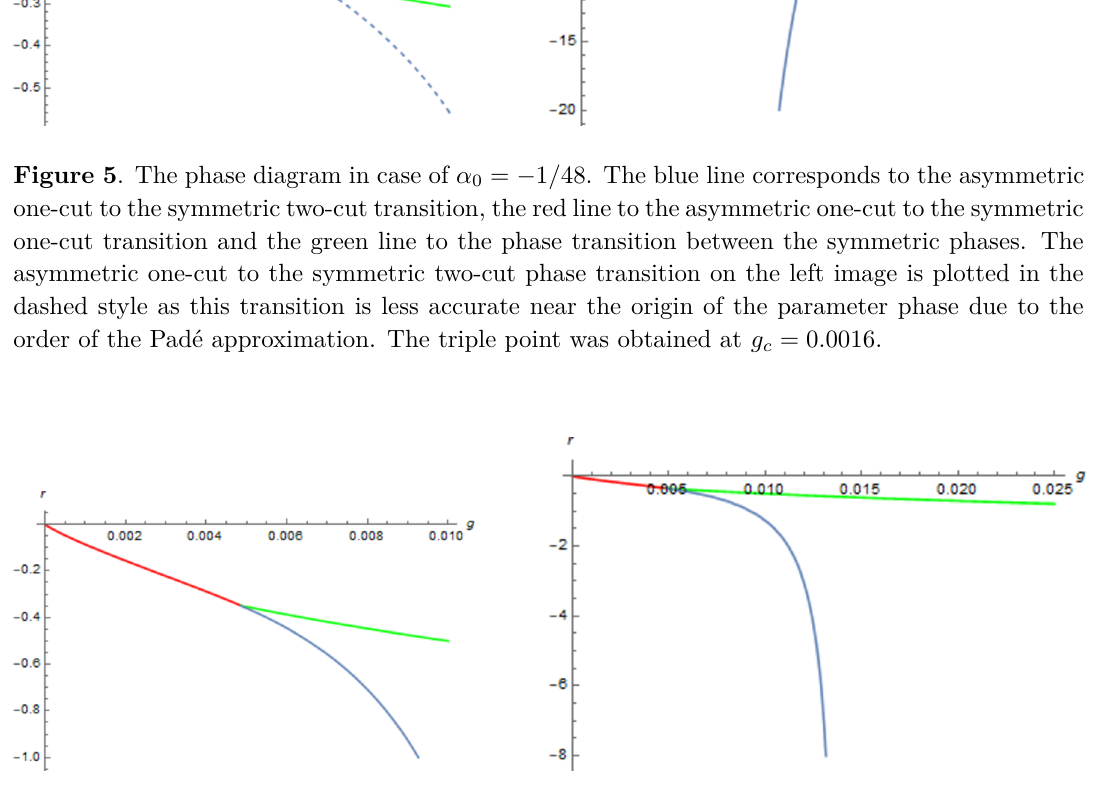
Figure 6 . The phase diagram in case of α 0 = 0 . The blue line corresponds to the asymmetric one- cut to the symmetric two-cut transition, the red line to the asymmetric one-cut to the symmetric one-cut transition and the green line to the phase transition between the symmetric phases. The triple point was obtained at g c = 0 . 0048